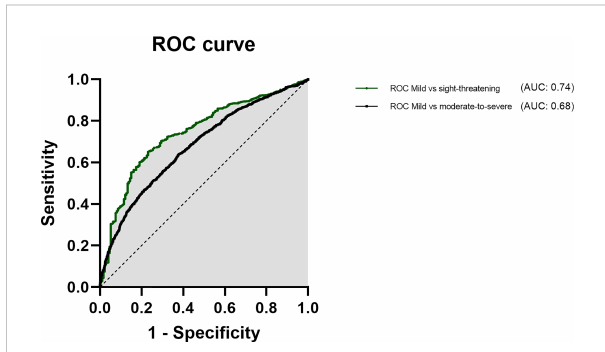
FIGURE 4 Area under the receiver operating characteristic curve for age, male sex and smoking as predictors for severe (black) and sight threatening GO (green).